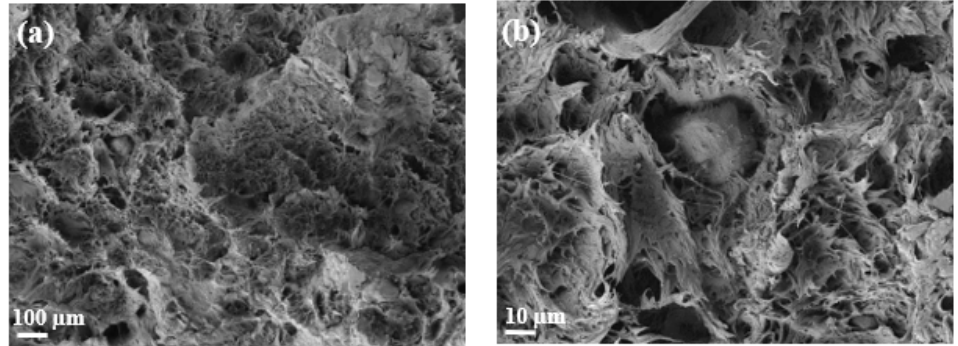
Figure 19. SEM micrographs of composites: ( a ) 40OP/PA/MAPP-rPP (500×); ( b ) 40OP/PA-rPP (2000×).